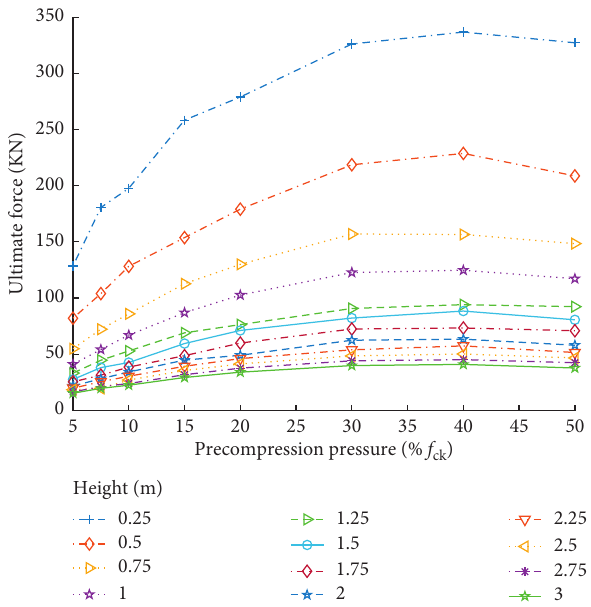
Figure 10: Ultimate displacement vs length for varying com- pressive strengths.